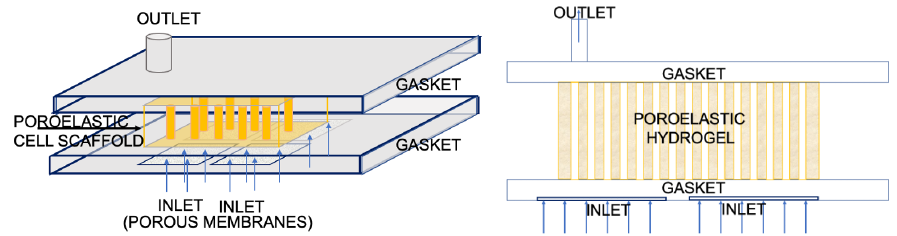
Figure 6. ( Left ): A 3D sketch of the prototype device (computational domain) showing the inlet through four semi-permeable membranes (four blue squares at the bottom), the hydrogel chamber (in orange); ultrafiltrate channels in hydrogel chamber (orange cylinders), and two gaskets—one at the bottom and one at the top of the hydrogel chamber. The anatomosis graft connected to the inlet and outlet is not shown. ( Right ): A 2D slice through the 3D device shown on the